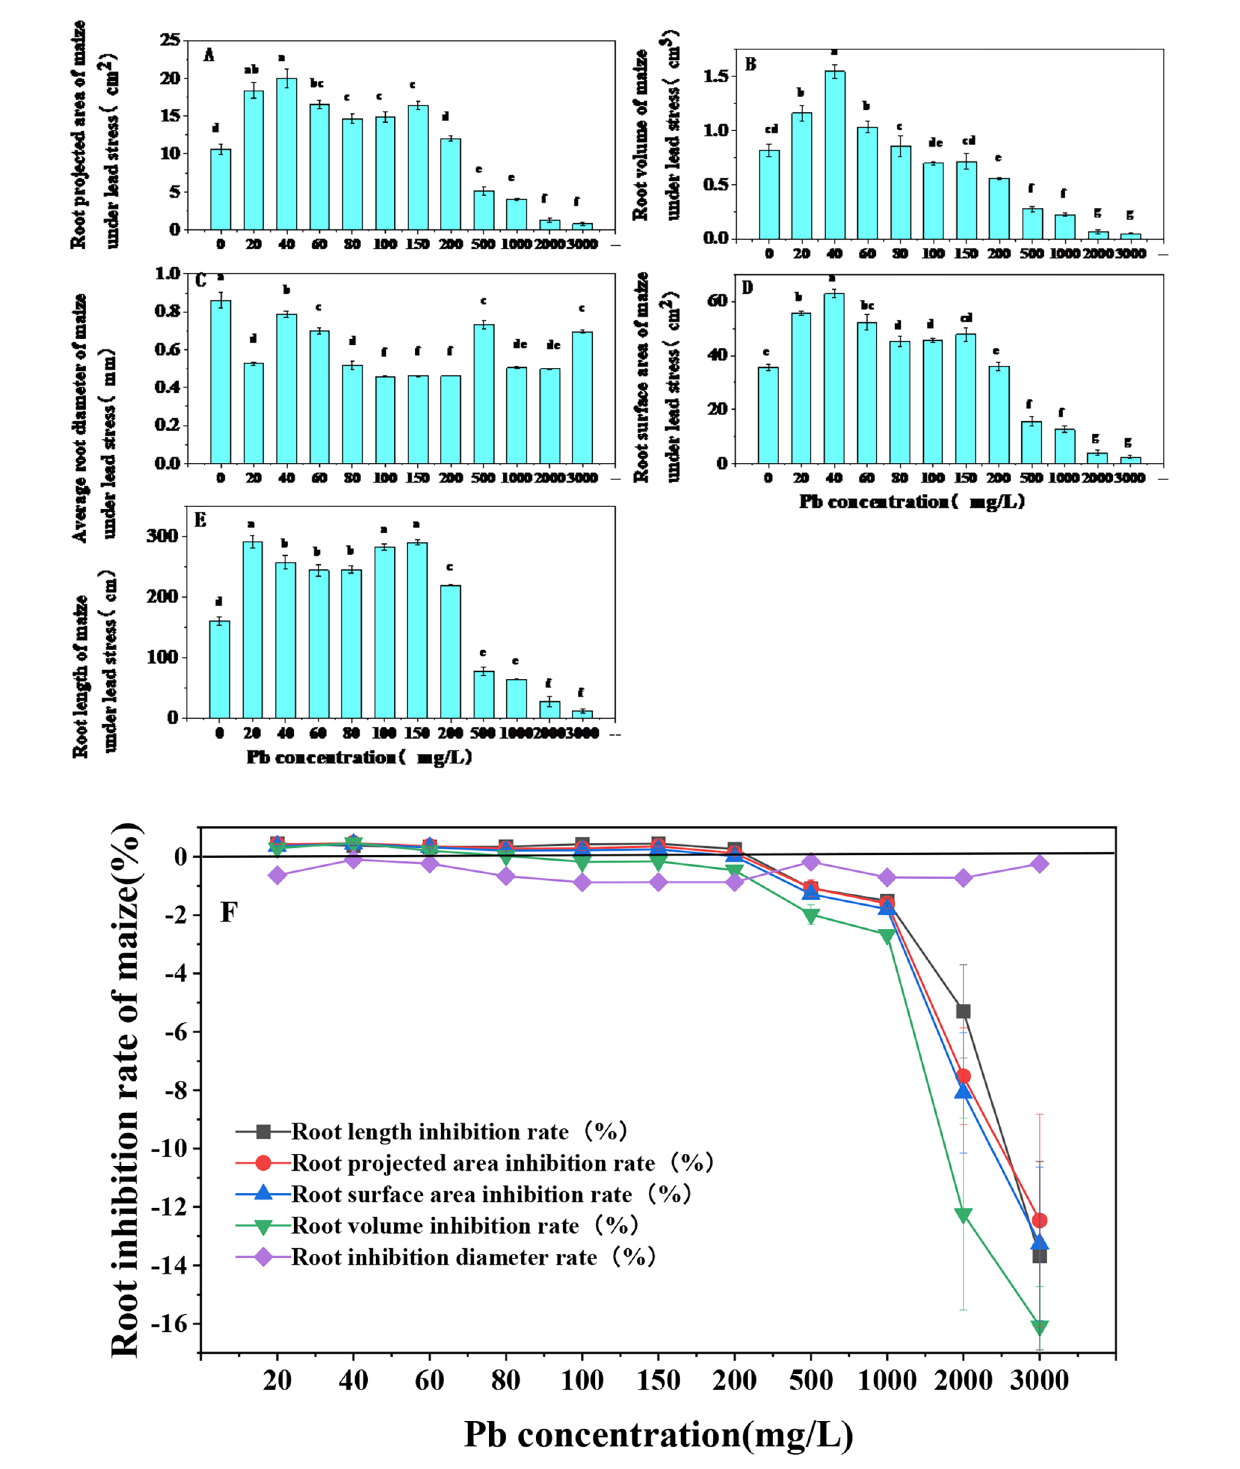
Fig. 4 Maize root system index under different Pb